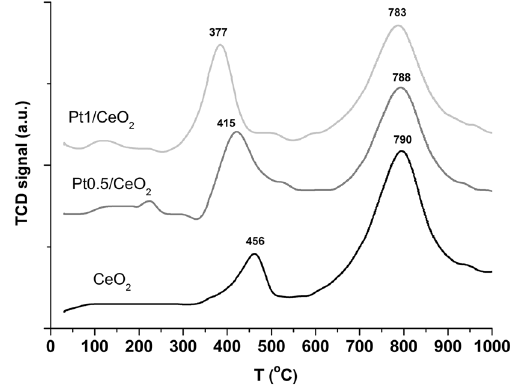
Fig. 3 H 2 -TPR profiles of CeO 2 support and Pt/CeO 2 catalysts